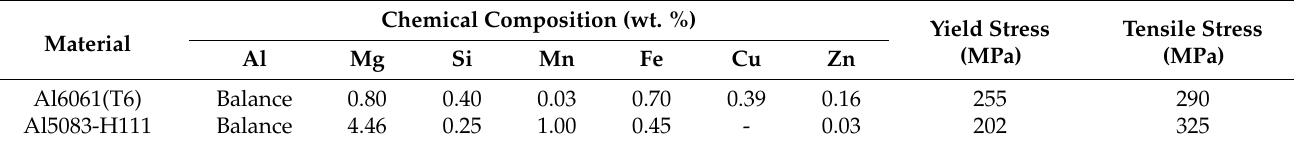
Table 1. Chemical compositions and tensile properties of the